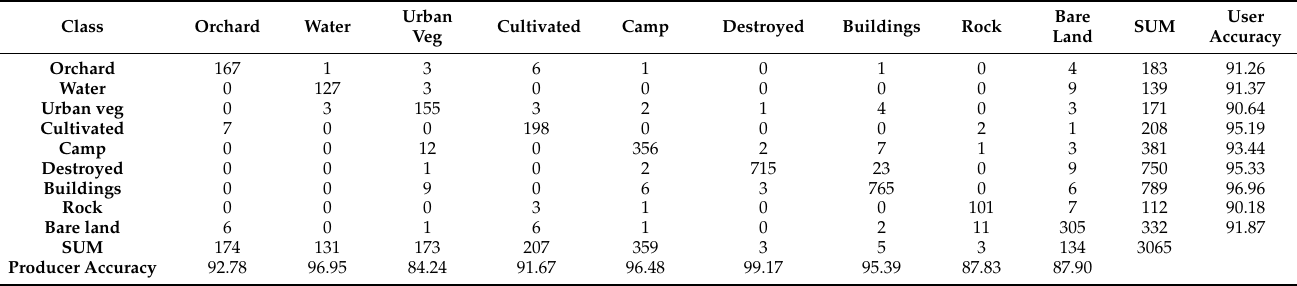
Table 4. User and producer accuracy assessment for each class.